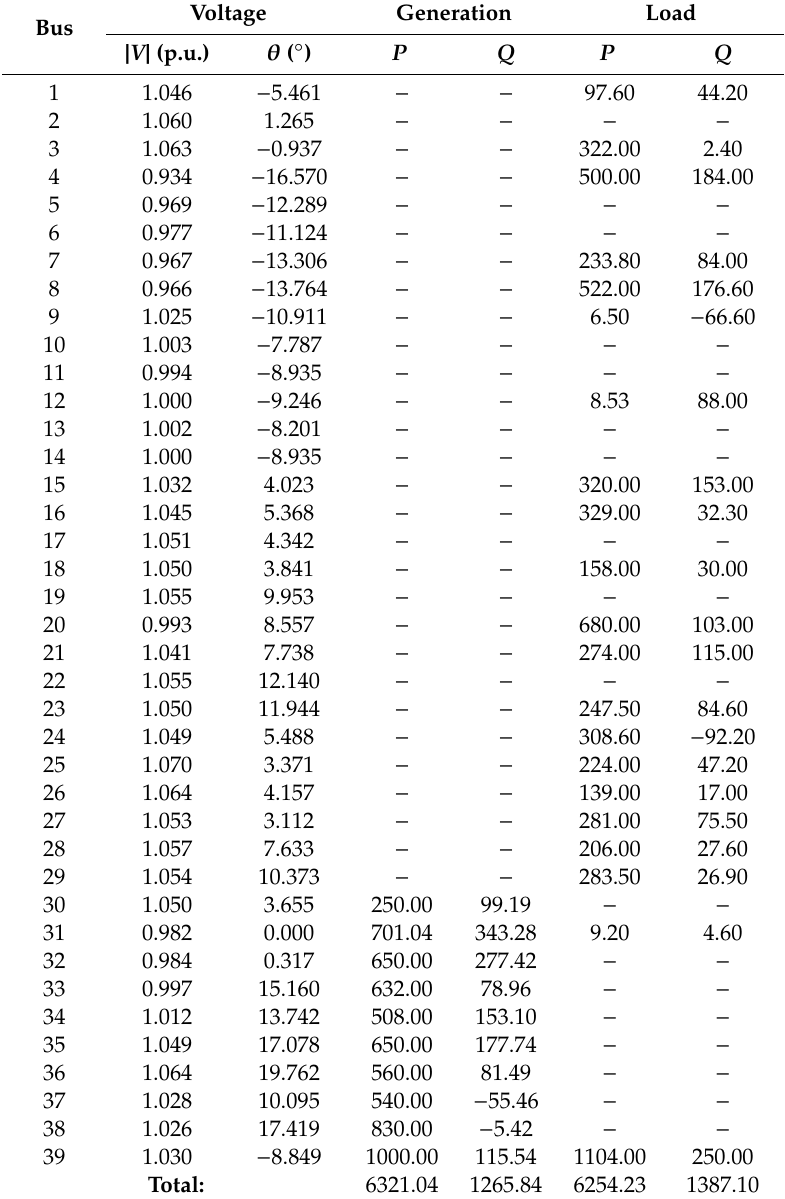
Table A46. Results of Mixed AC / DC PF calculations in Case 7-5. AC bus